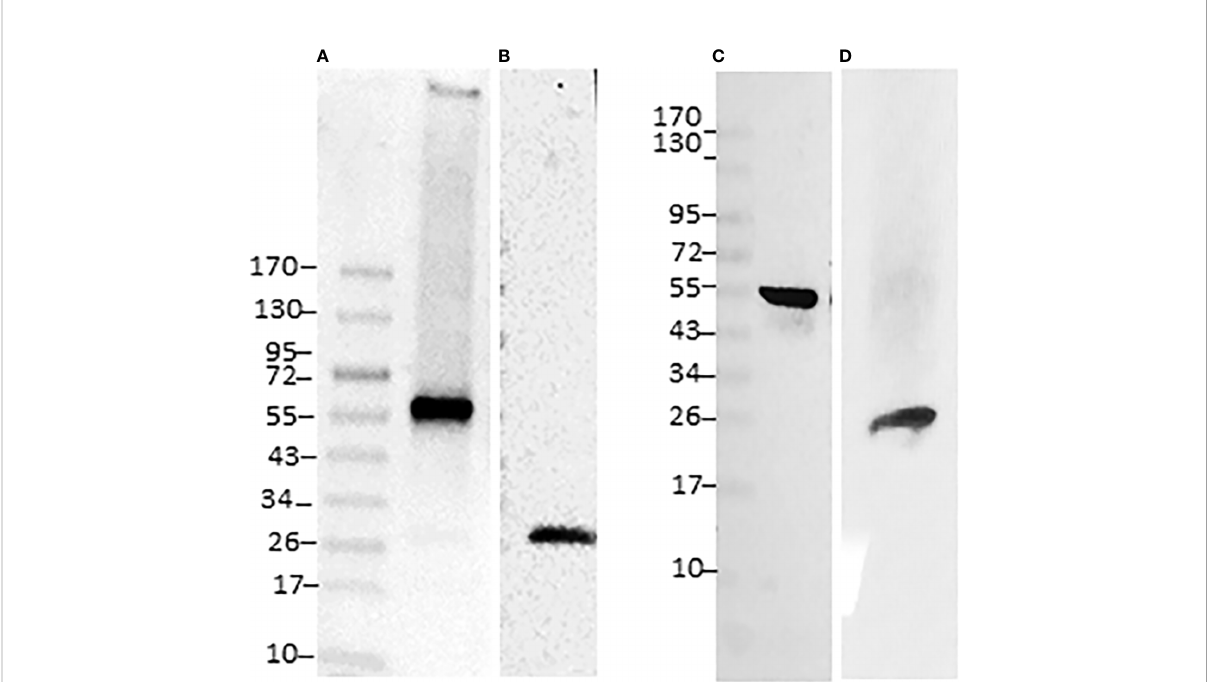
FIGURE 3 Immunoblotting of E . chaffeensis and host proteins identi fi ed in phagosome membranes. Twenty micrograms of proteins per lane were separated on a 4-20% SDS-PAGE gel, the resolved proteins were transferred to a nitrocellulose membrane and immunoblotted with Ehrlichia polyclonal antibodies speci fi c to speci fi c DnaK (A) and p28 monoclonal (B) or with host phagosome protein antibodies speci fi c to lamin-B (C) and Rab5 (D) . Speci fi c antigen-antibody interactions were visualized with horseradish peroxidase-conjugated secondary antibodies and detected using ECL.